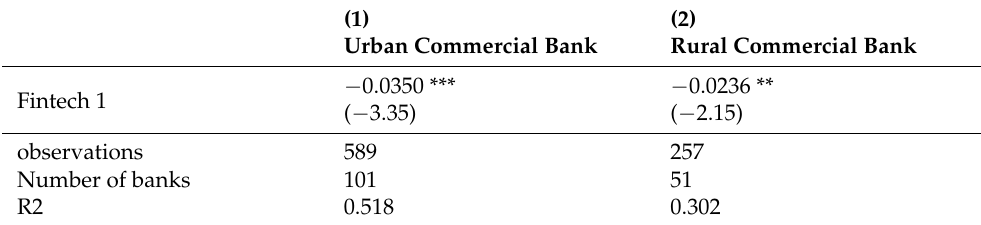
Table 12. Heterogeneity test results of banking